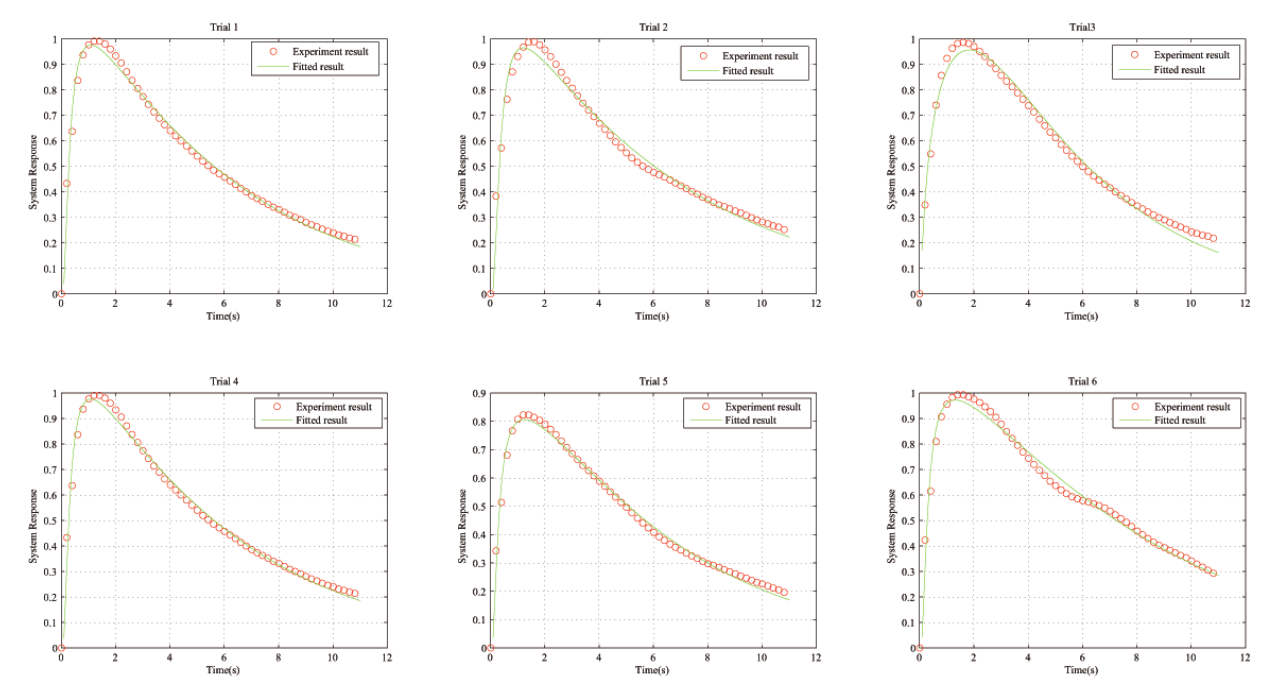
Figure 6. System response and the (cid:12)tted model for set of 6 trials